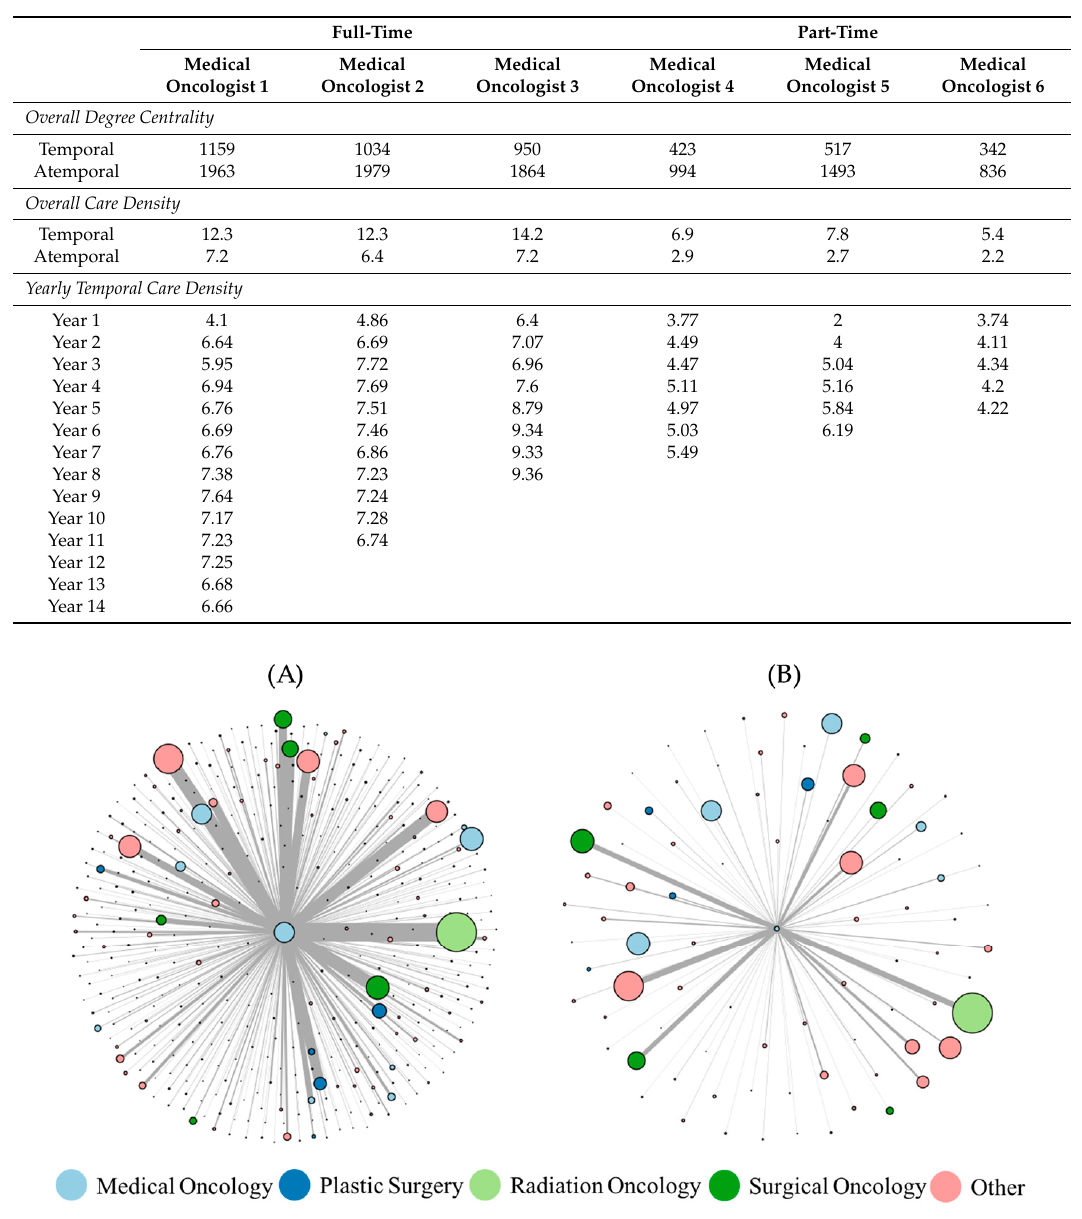
Table 4. Medical oncologist care densities, relative to date at which each provider entered the network.